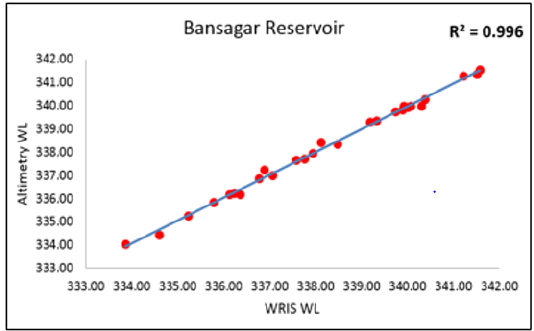
Figure 7. Accuracy of Altika estimated and field measured water level for Bansagar reservoir